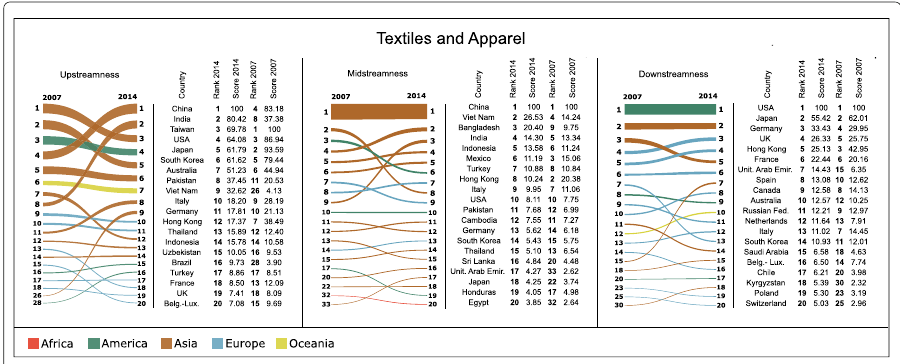
Fig. 4 Bump charts showing the variation in rankings and values of upstreamness ( left-handcolumn ), midstreamness ( centrecolumn ), and downstreamness ( right-handcolumn ) centralities of countries in the Textiles and Apparel industry between 2007 and 2014. Each line in the bump charts shows the variation of ranking for each country, and the width of each line at the two endpoints is proportional to the centrality score in the corresponding year. Only the 20 top-ranked countries in 2014 have been included. The scores underlying the two rankings in each bump chart have been normalised so as to produce equal sums of widths of endpoints at each year. Beside each bump chart is a table illustrating the rankings and centrality scores normalised according to Eqs. 5, 7, and 9. The colour of each line in the bump charts refers to the geographic continent of the corresponding country. Bump charts were obtained using